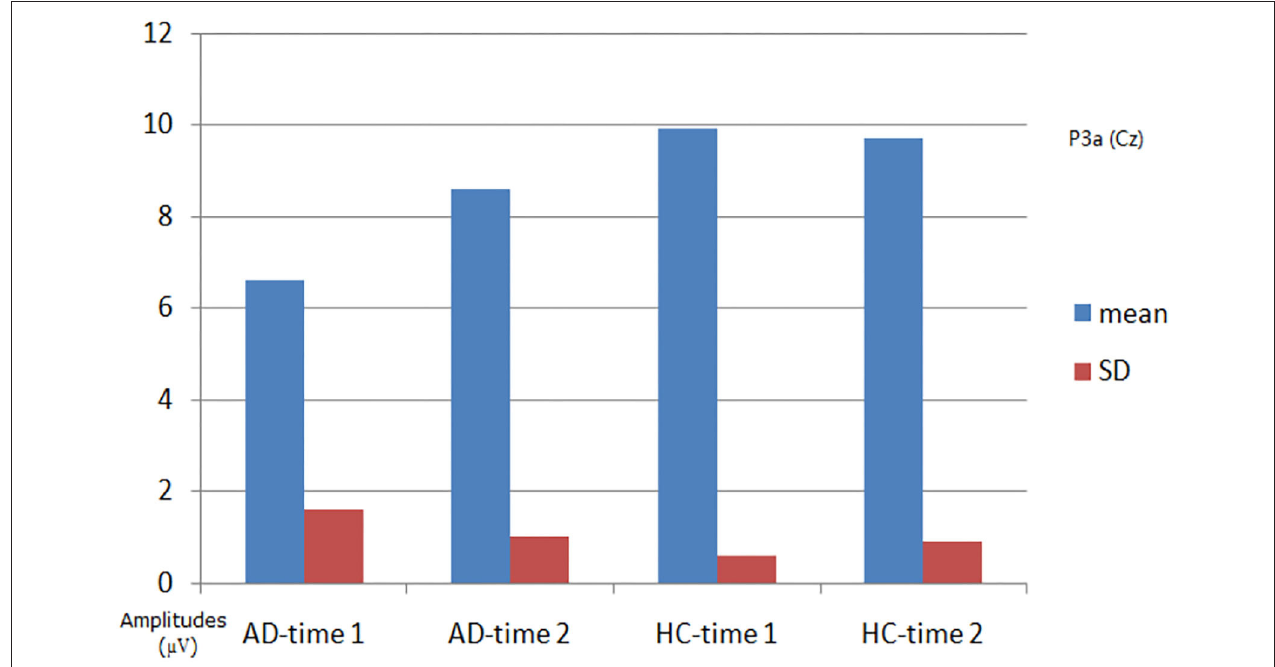
FIGURE 3 | Plot of P3a amplitude analysis. The interaction effect for group × time point was significant; the simple effect for group at time 1 level and time 2 level was significant; the simple effect for time point at the alcohol dependence (AD) group level was significant; the simple effect for time point at the healthy control (HC) group level was not